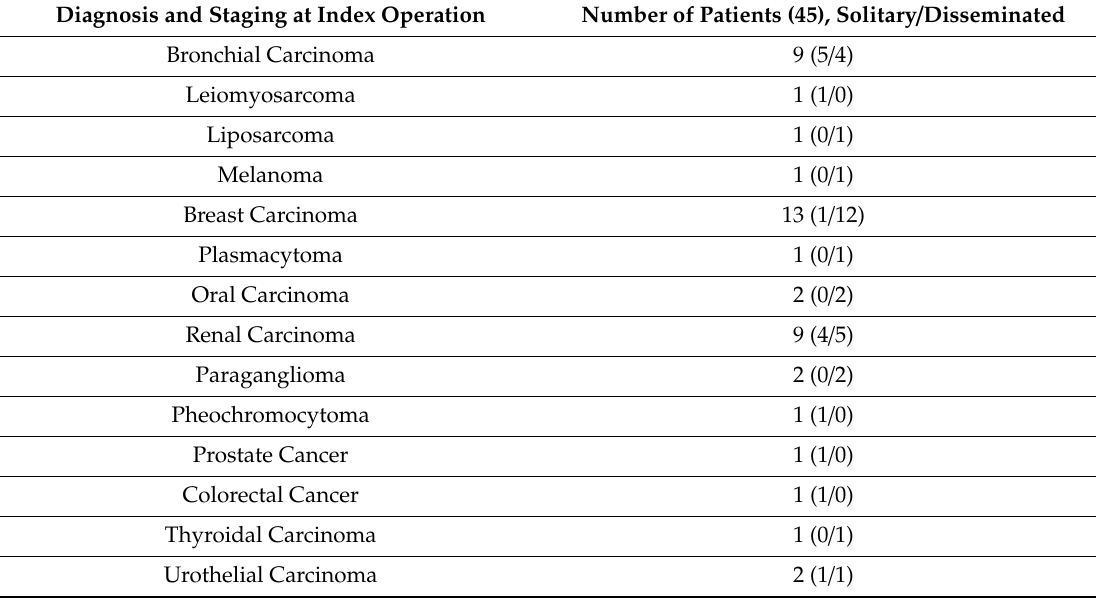
Table 1. Diagnosis and staging at the time of index operation.